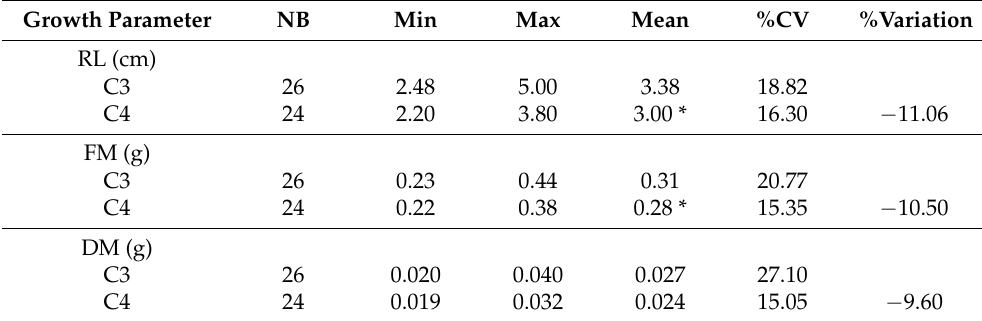
Table 2. Growth parameters of V. faba roots after 48 h of exposure to C3 (EC: 2.01–2.24 dS m − 1 ) and C4 (EC: 3.46–7.00 dS m − 1 ) water.